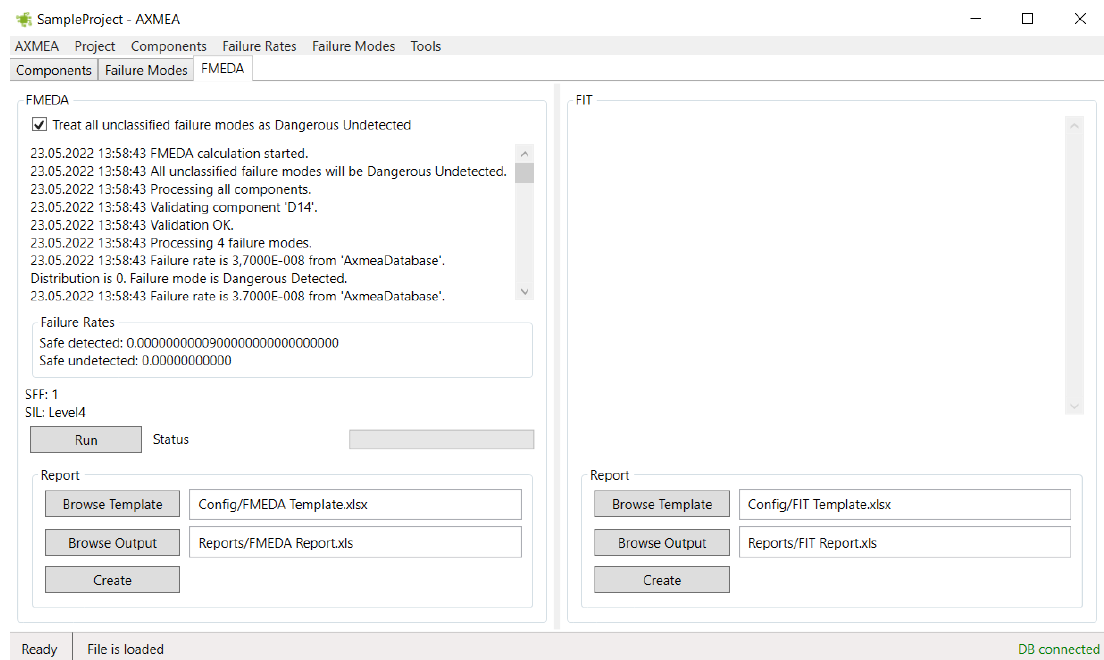
Figure 8. AXMEA tool: specification of severity and detectability. Basic safety and reliability metrics provided by AXMEA include failure rates classi- fied according to IEC 61508 [57] requirements, safe failure fraction, diagnostic coverage, and safety integrity level (Figure 9).